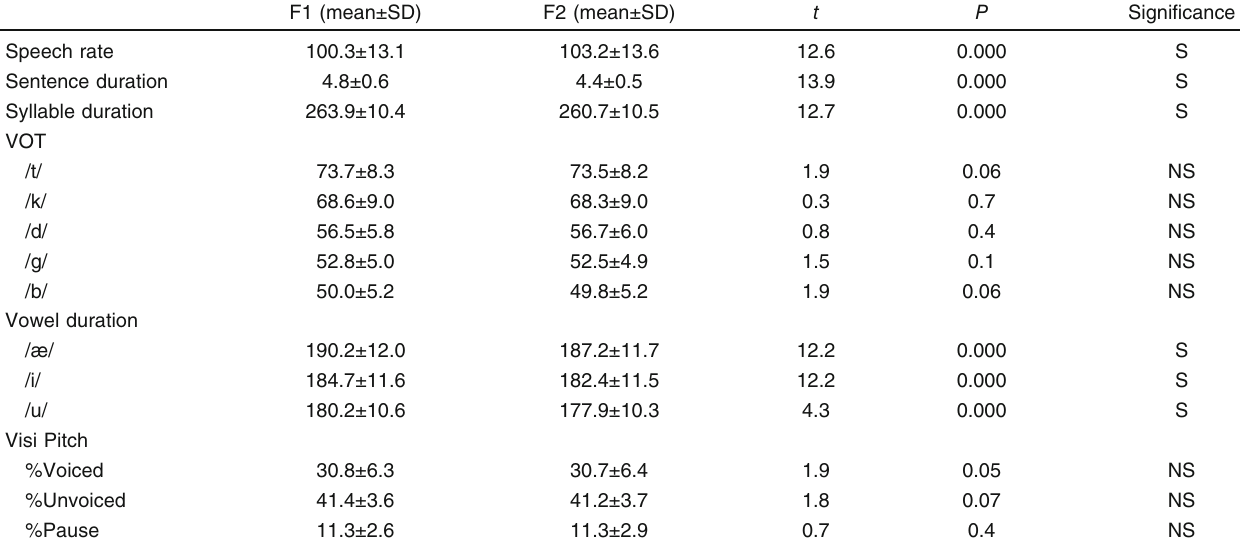
Table 12 Correlation between first follow-up and second follow-up in the study group as regards speech rate, sentence duration, syllable duration, voice onset time, vowel duration, and Visi